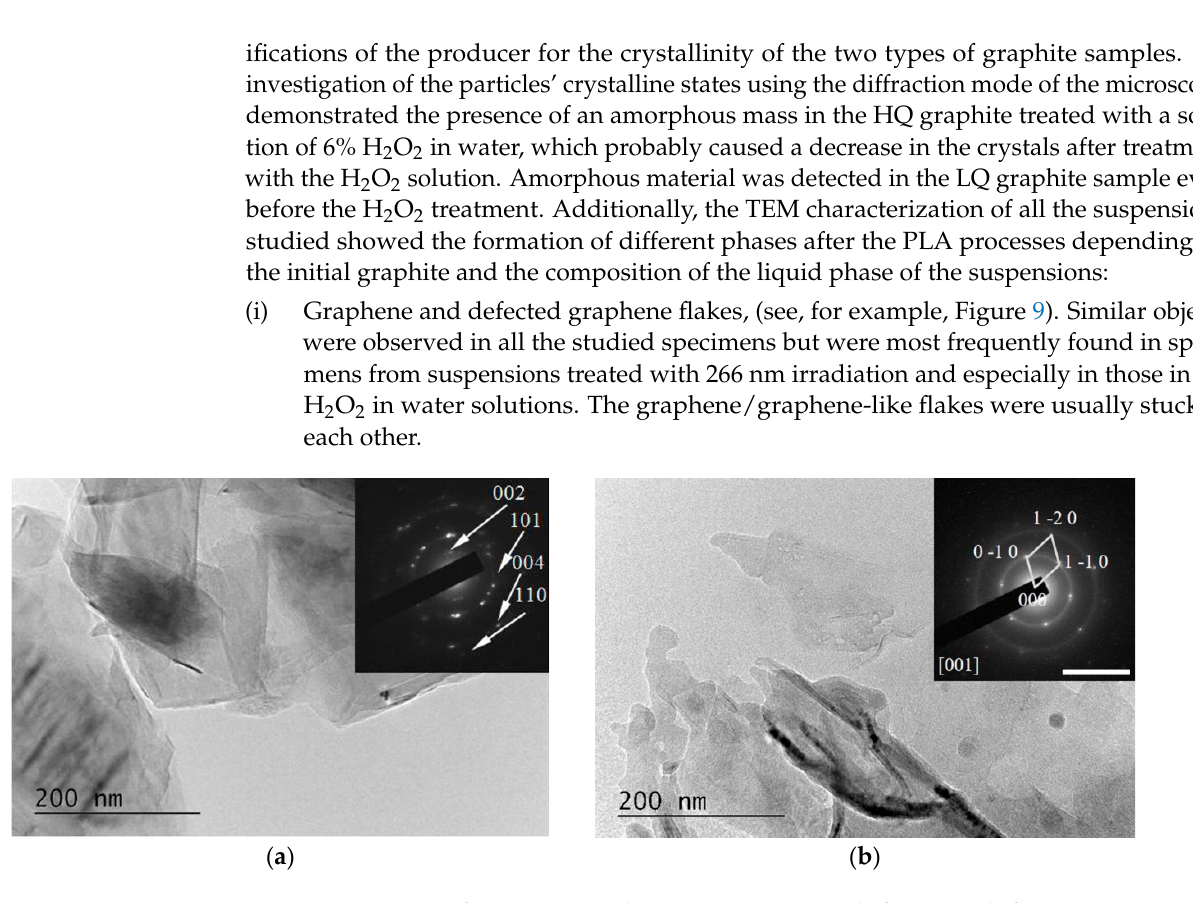
11 of 16 Figure 8. XRD pattern of LQ ( a ) and HQ ( b ) specimens. 3.4. TEM Characterization The specimens for the TEM studies were prepared by dropping and drying a drop of any suspension obtained on formvar-covered TEM grids. It should be emphasized that due to the method of obtaining the samples, the visualized nano-sized objects were stuck